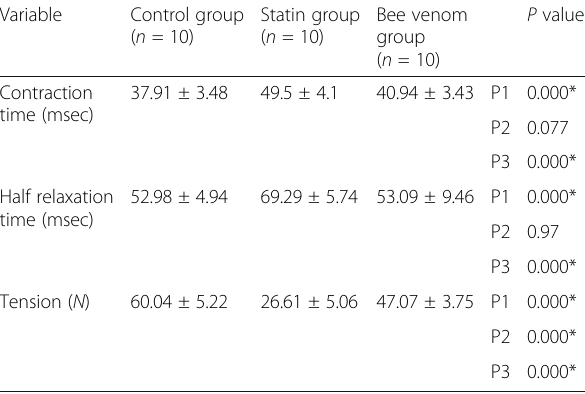
Table 4 In vitro assessment of contractile function of